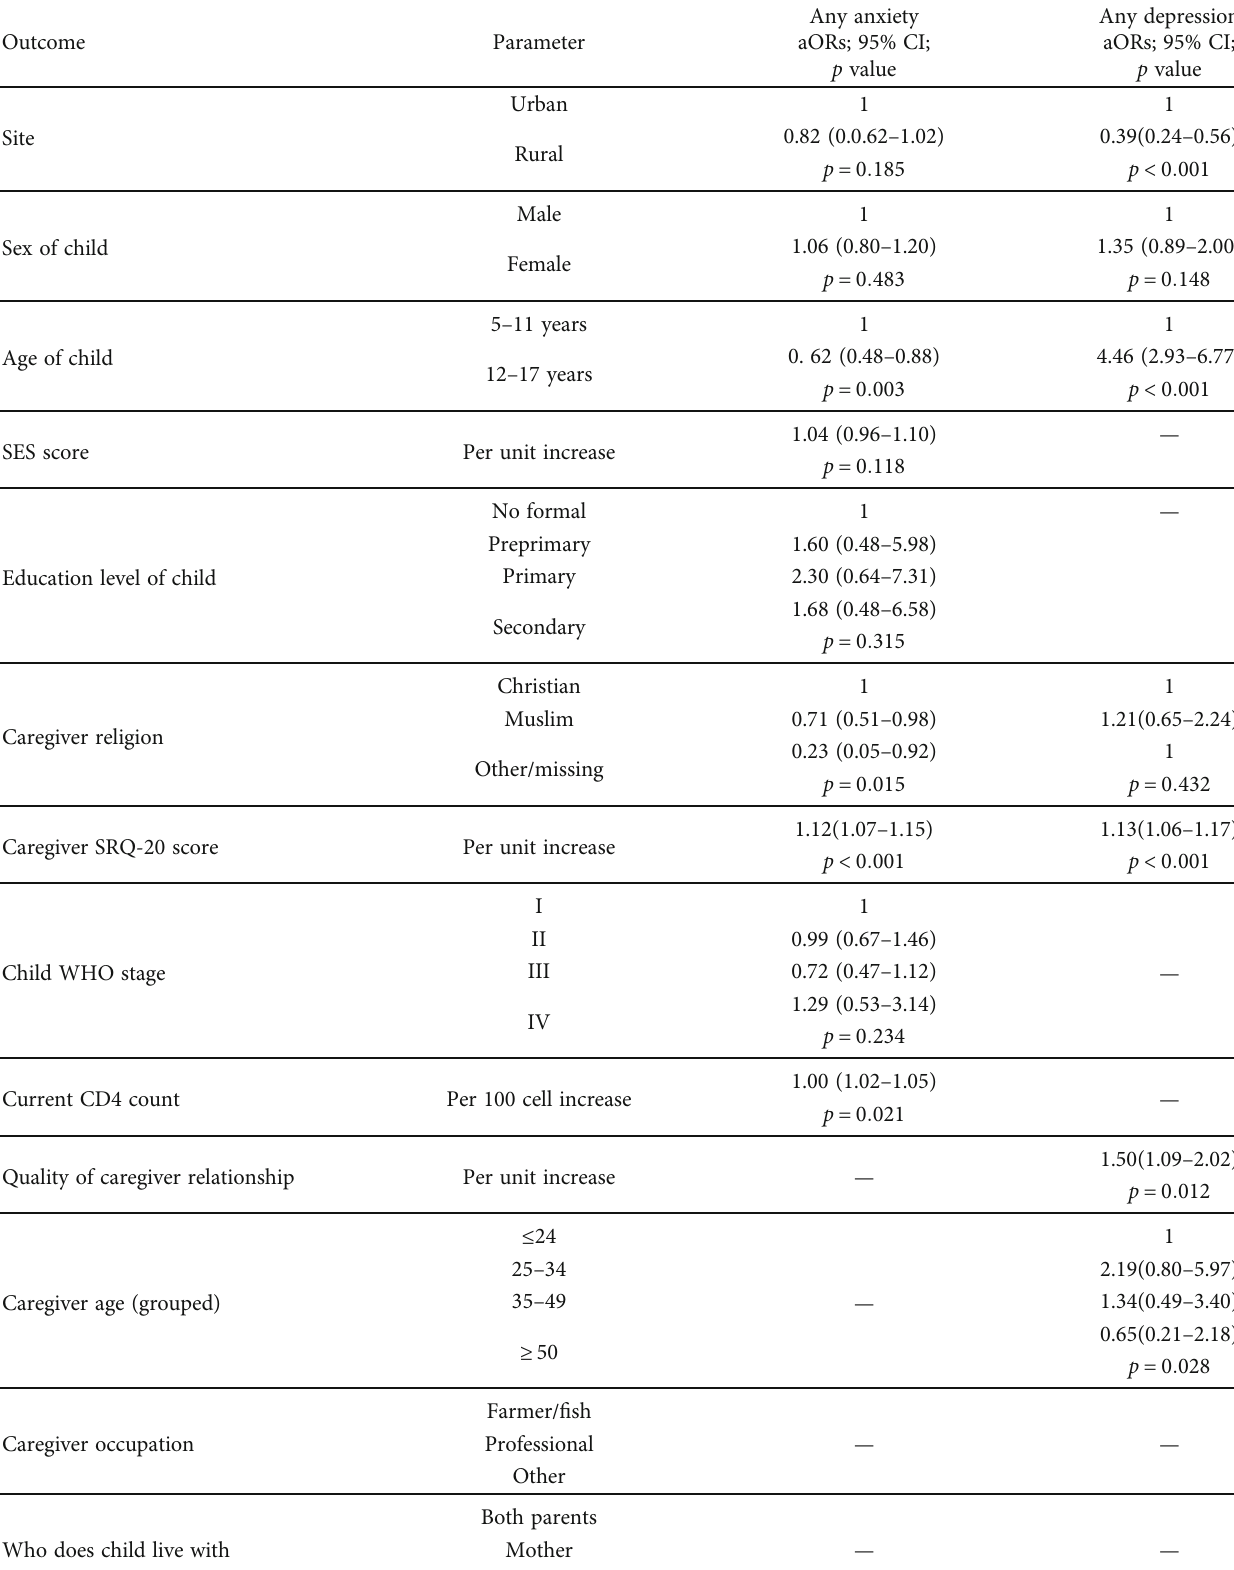
Table 4: Factors associated with anxiety and depressive disorders: results of fi tting logistic regression models including comorbidities.